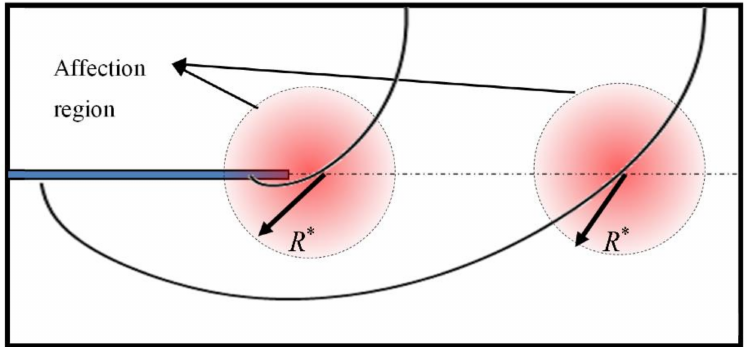
Figure 13. A ff ection on predictor area by uncounted failure